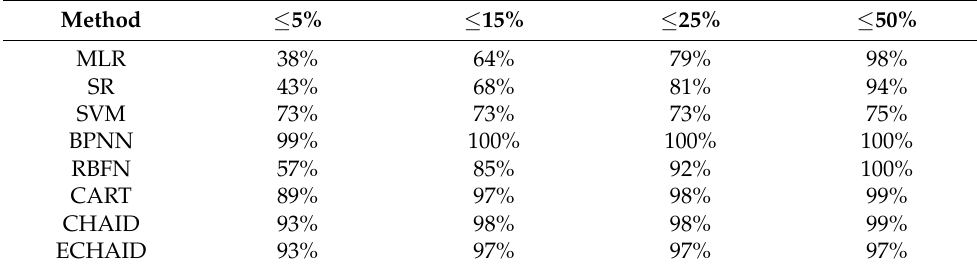
Table 4. Range of relative errors for the eight electricity consumption prediction